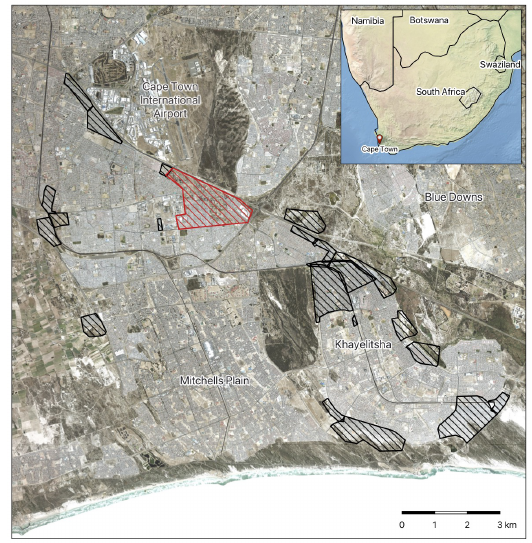
Figure 2. Aerial imagery indicating the region areas digitised in Khayelitsha, South Africa. (Polygon 11 shown in